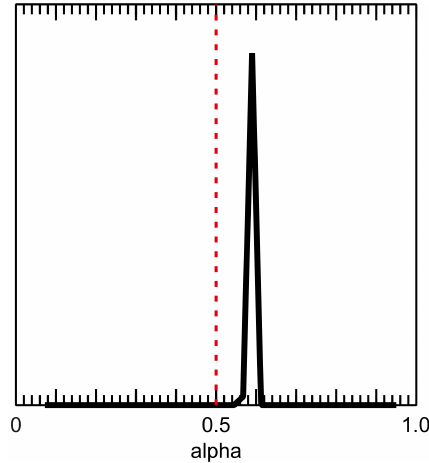
Figure 8. Results from inversion: PDF of the parameter α